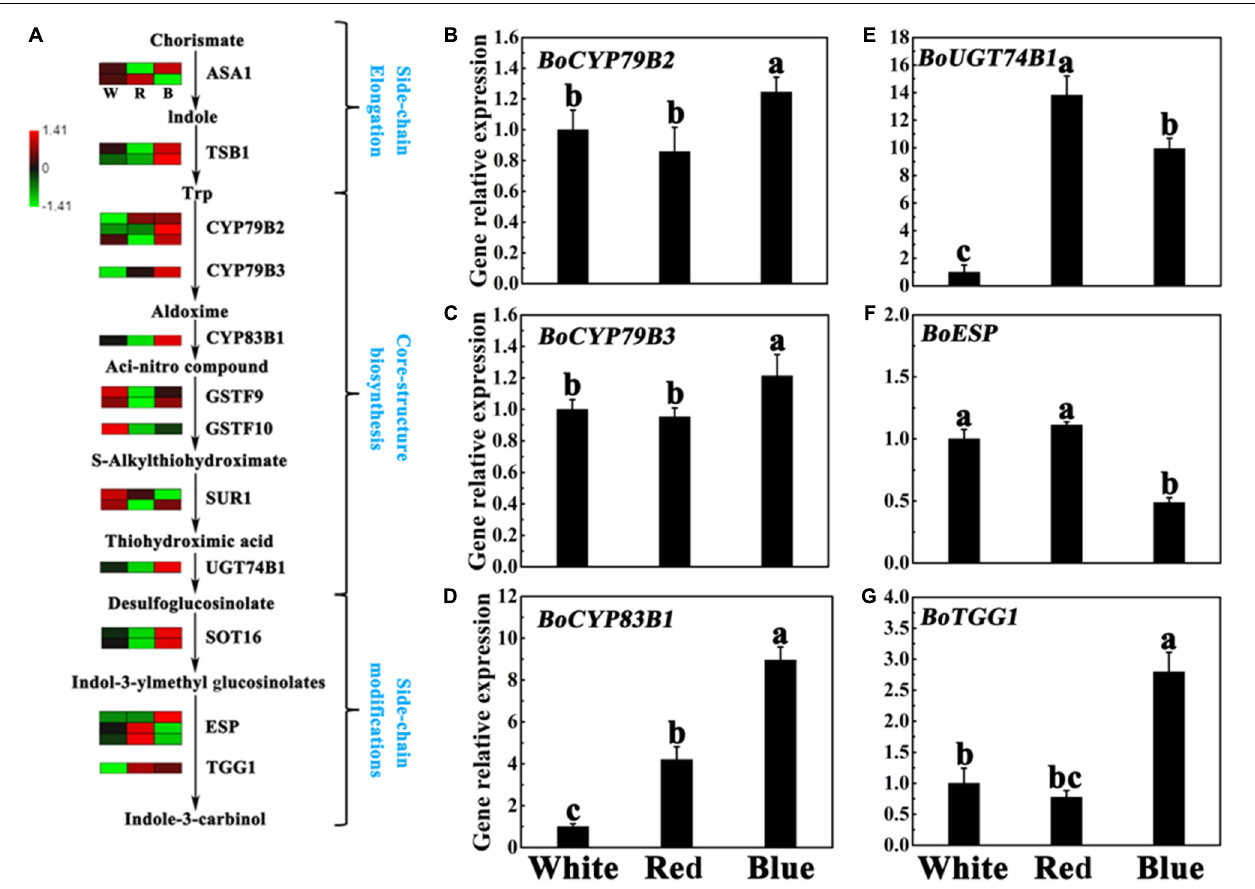
FIGURE 5 | Expression of I3C synthesis-related genes under different lights. (A) Flow chart of I3C biosynthesis. The heat map shows the differences in the expression of genes related to I3C synthesis in broccoli sprouts under different lights. The values of log 2 [fold change (FC)] was represented using the depth of color, with green representing low expression and red representing high expression. Fold change means the ratio of the gene expression in blue light treatment to it in control. (B–G) Transcript analysis of I3C biosynthesis-related genes in broccoli sprouts with different light treatments. Data represented as means ± SD from three independent experiments. Different letters indicated statistical differences ( P <